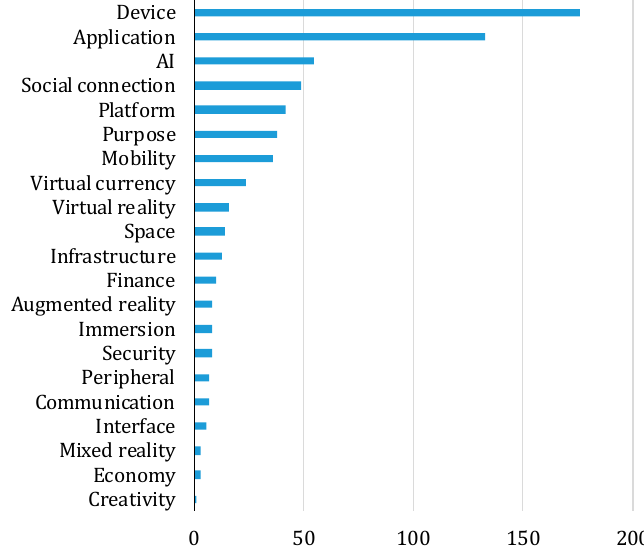
Figure 1. The most frequently used terms for virtual worlds.